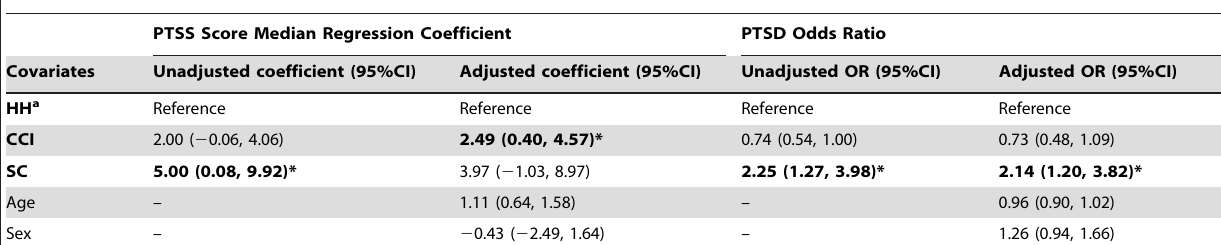
Table 3. PTSS Median Score and PTSD association with care environment.